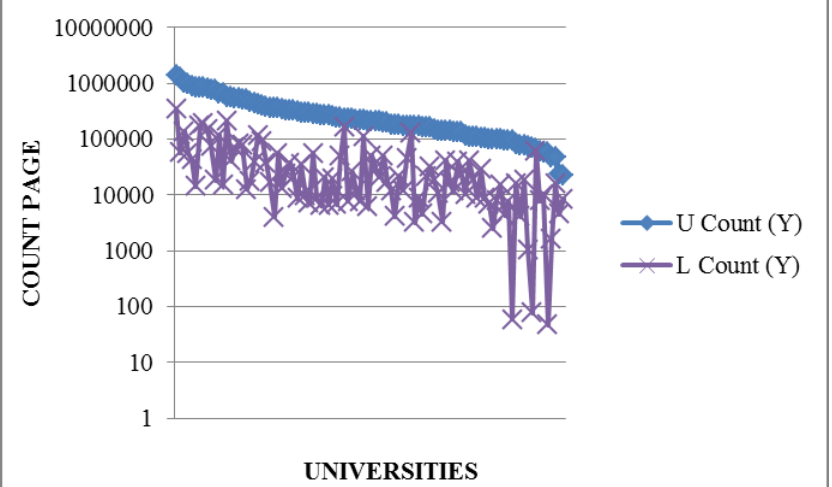
Figure 3. Distribution of page counts for universities (U) and academic libraries